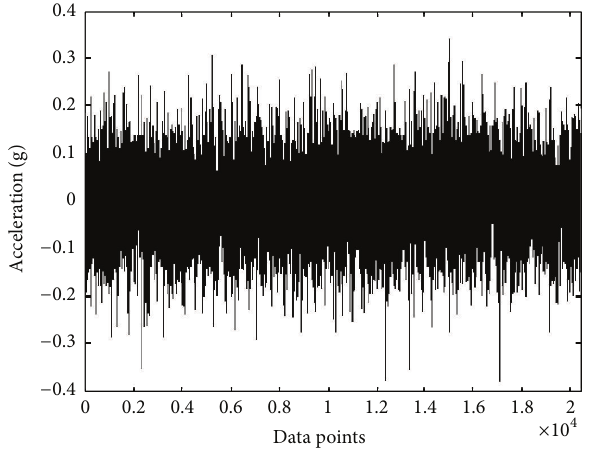
Figure 3: Vibration signal.